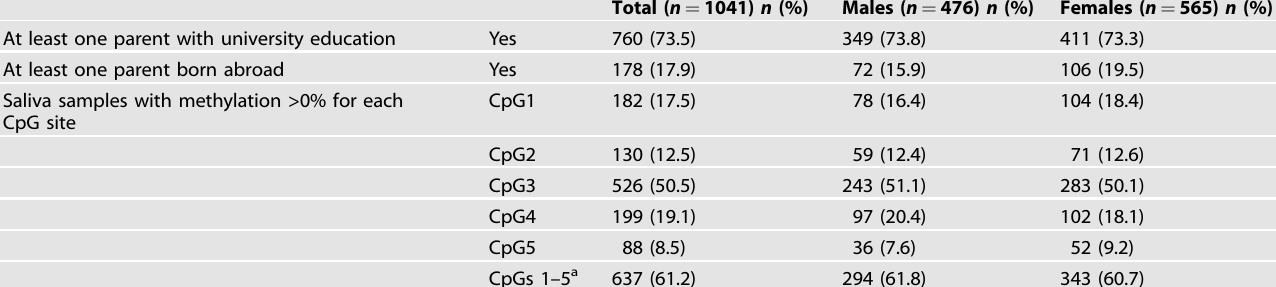
Table 1. Characteristics of the study population at baseline (13 – 14 years of